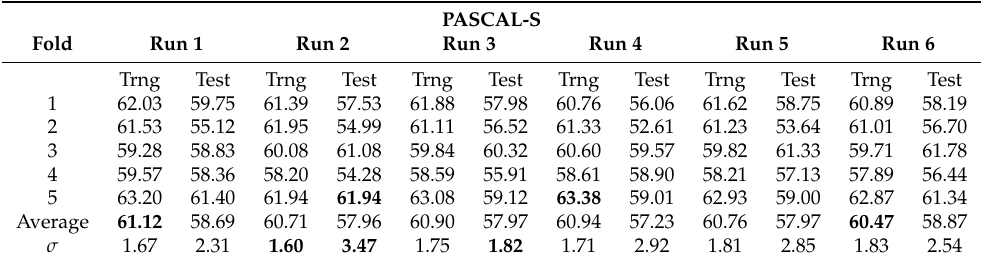
Table 15. Performance of the best individuals of the GBVSBP model for all PASCAL-S database runs. Each pair of training and testing corresponds to one experiment of the k-fold. Therefore, we obtain 30 executions of our system and report the standard deviation for each run set.